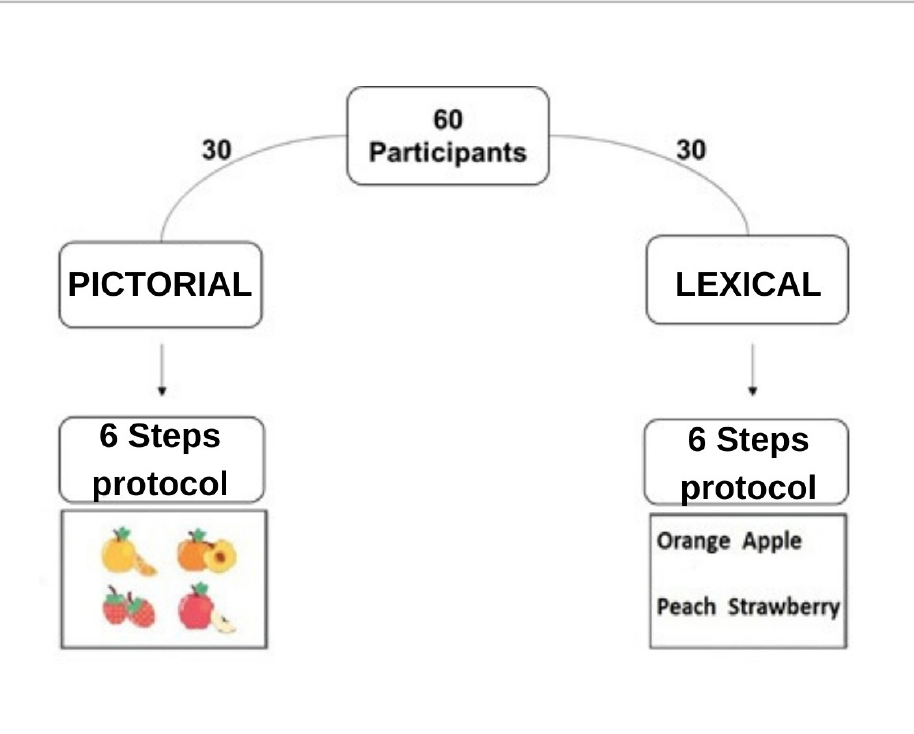
FIGURE 1 – Scheme of the experimental